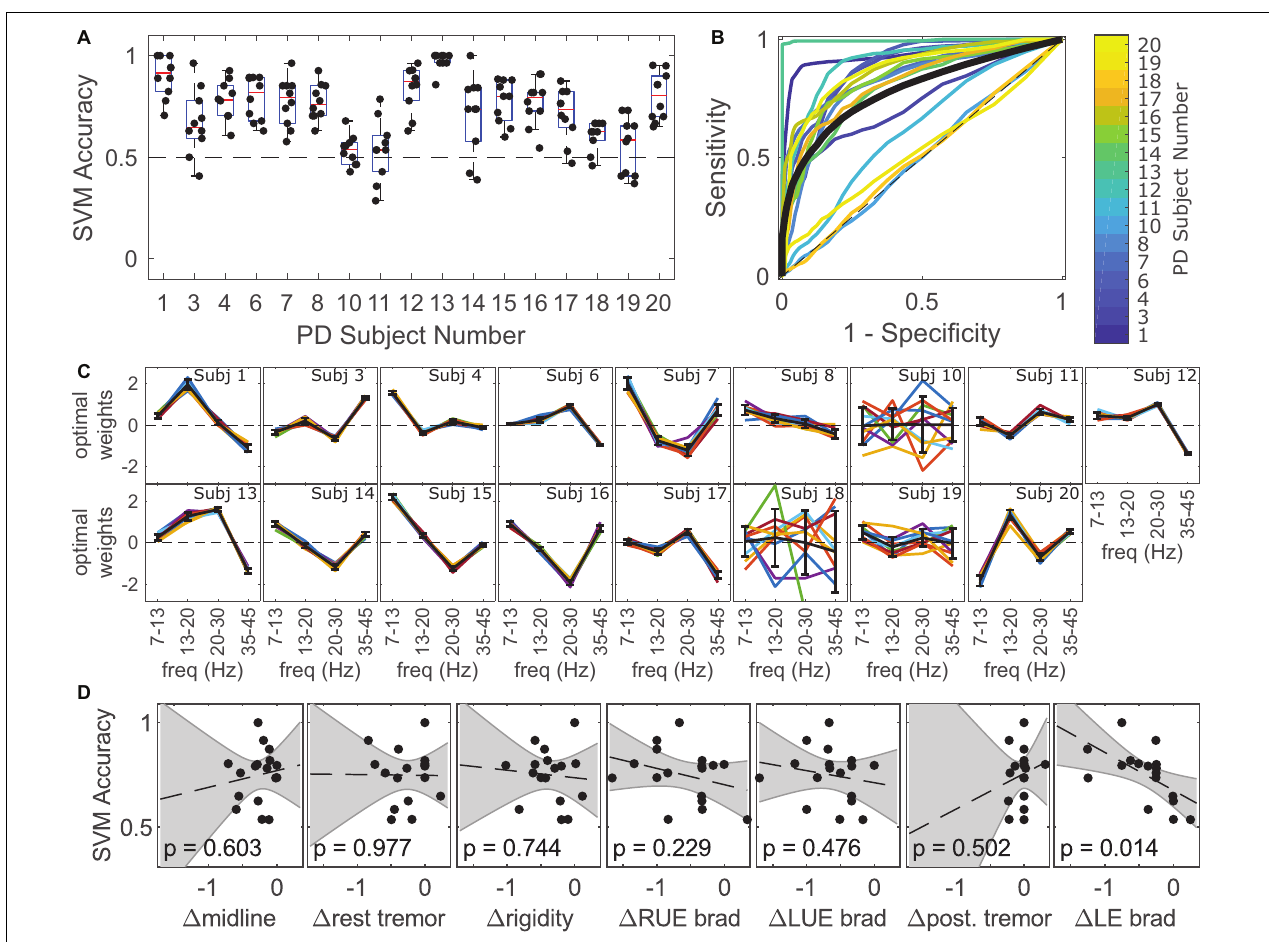
FIGURE 2 | Individual profiles of MEG responses in terms of frequencies that best distinguished between LEVODOPA-OFF and LEVODOPA-ON within subjects. (A) Accuracy of within-subject linear support vector machine (SVM) in distinguishing between LEVODOPA-OFF and LEVODOPA-ON with 10-fold cross validation. Each dot is a separate fold. An accuracy of 0.5 is a random-chance prediction (black dashed line). (B) Average Receiver Operating Characteristic (ROC) curves across folds for each subject (colored lines) and the grand average ROC curve across subjects (black solid line). The dashed black diagonal line denotes the chance line. (C) MEG response profiles in terms of frequency band weights for each individual subject across all folds (colored lines) and averages across folds (bold black lines). Features were standardized to zero mean and unit variance. Positive weights reflect increase due to medication. Error bars denote the standard deviation of weights across folds. (D) Linear regression between median classification accuracy from (A) and clinical change in factor scores. Dashed lines show the linear fit for each factor. Shaded areas show the 95% confidence interval of the linear fit ( p -values and confidence intervals not adjusted for multiple comparisons). Subjects 2, 5, and 9 were not included in SVM analysis due to prominent muscle, tremor, or imaging artifacts,